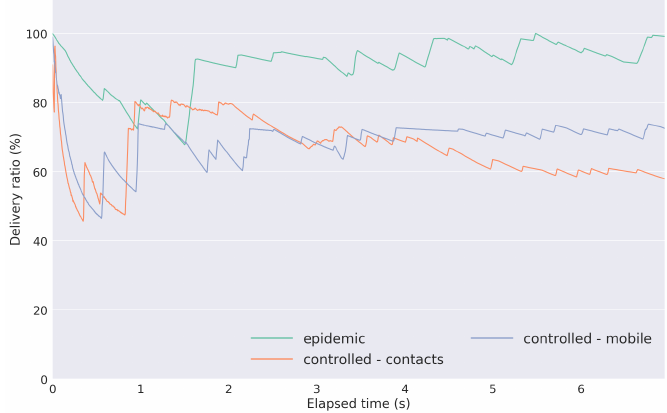
Figure 18. Delivery ratio results.